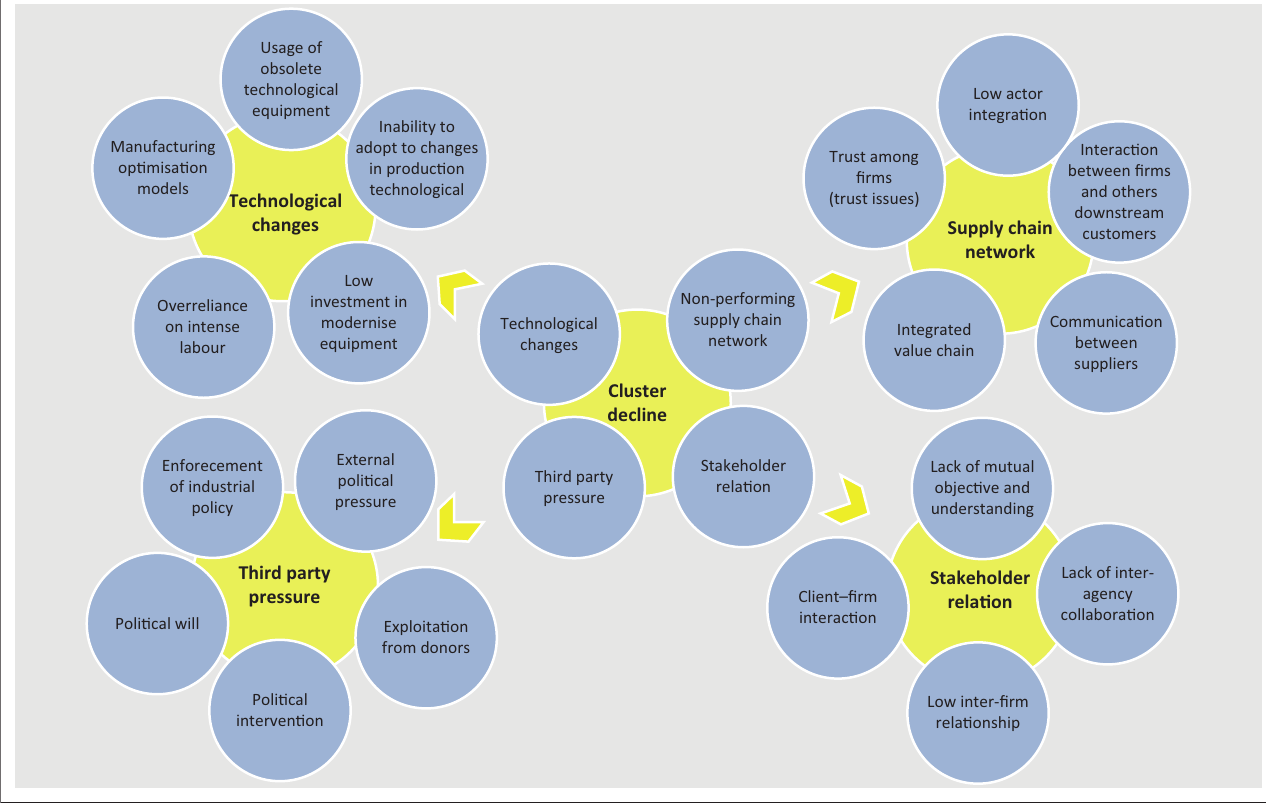
FIGURE 1: Conceptual